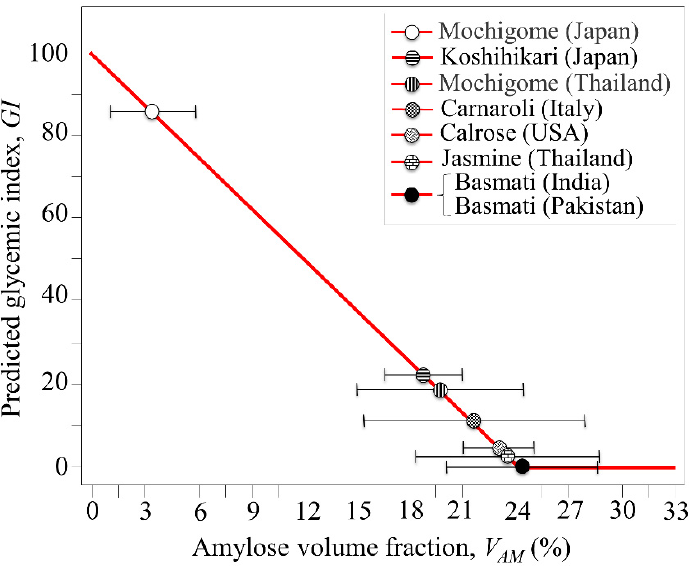
Figure 9. Predictive trend for postprandial glycemic index, GI , for eight rice cultivars (cf. labels) as a function of their amylose volume fraction, V AM , from Raman spectroscopy. The plot is based on clinical data from ref. [33].